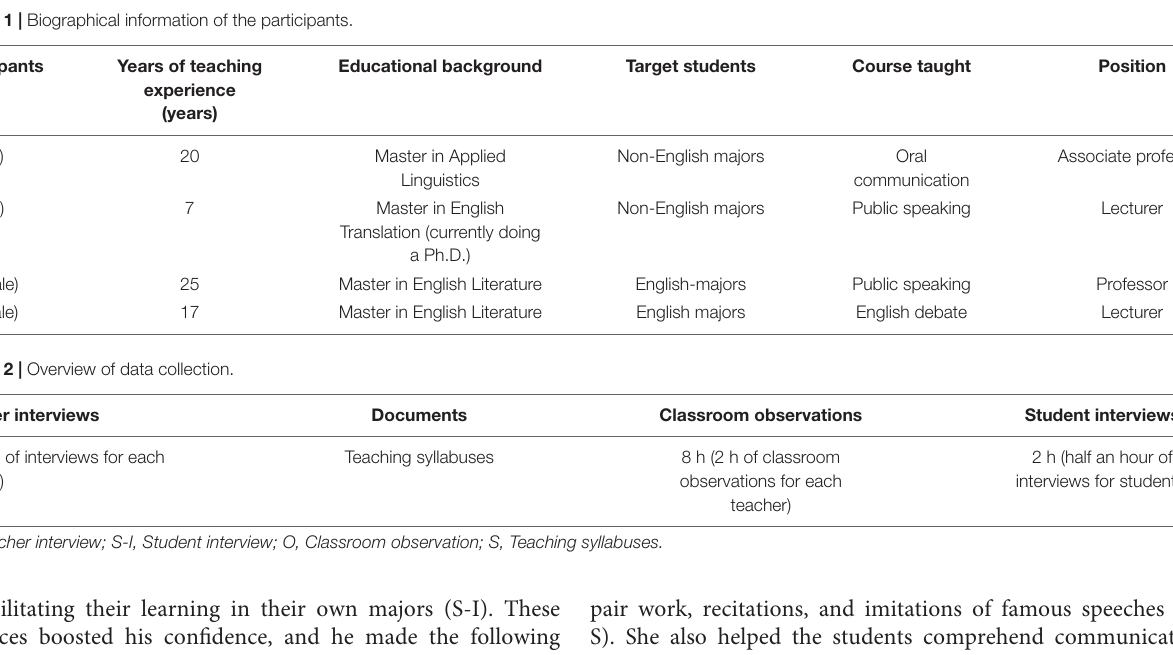
TABLE 1 | Biographical information of the participants.